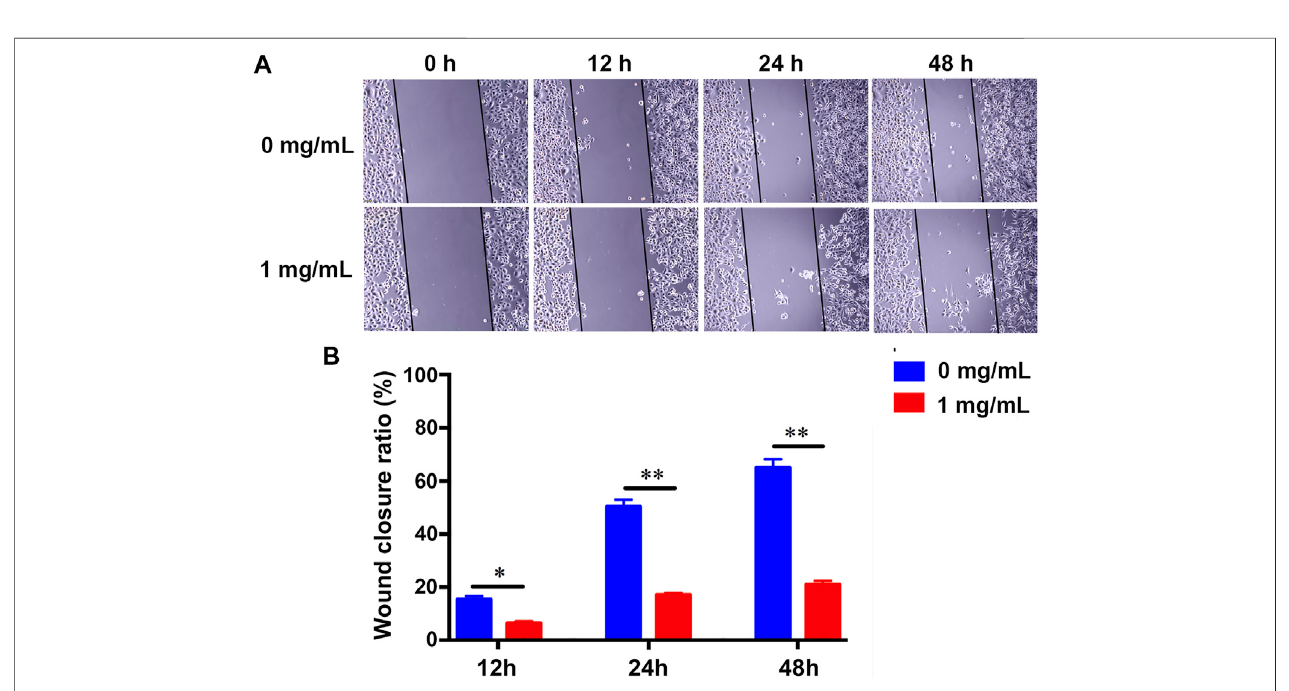
Frontiers in Bioengineering and Biotechnology |